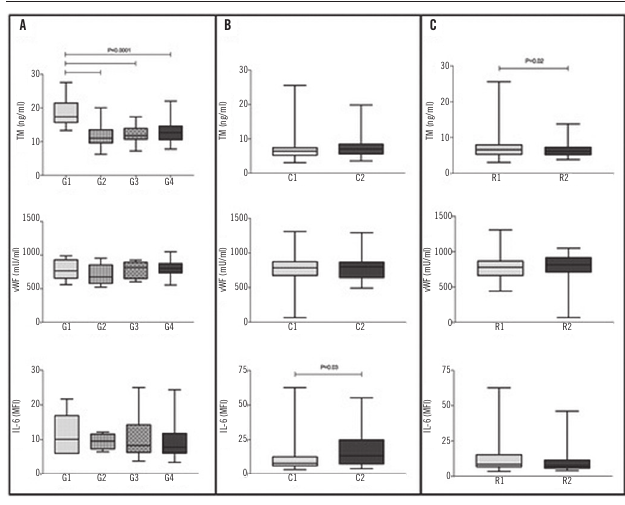
figurE 1 − Plasma concentration of TM, vWF and IL-6 from renal transplant recipients (RTR) Plasma levels of TM, vWF and IL-6 according to primary cause of end-stage renal disease (ESRD) (A), creatinine plasma concentrations (B) and eGFR (C) in groups of RTR. All results are presented as median, minimum and maximum values. Data are expressed in ng/ml (TM), mU/ml (vWF) and MFI (IL-6); G1: glomerulopathy; G2: hypertensive